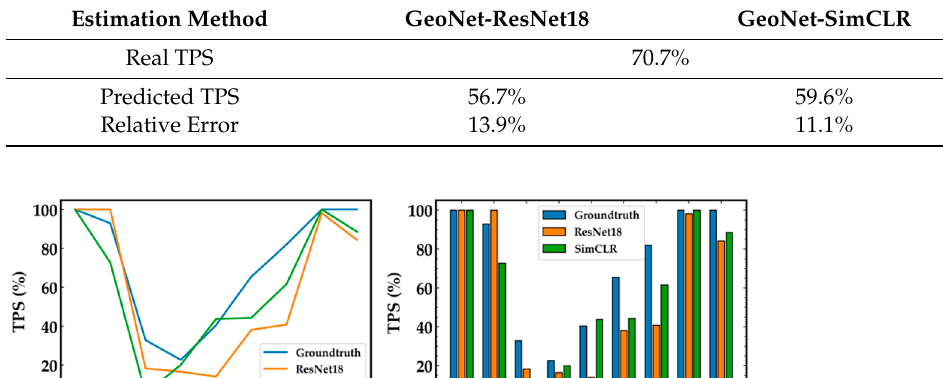
Table 5. Average TPS values of the unlabelled set of LUSC.